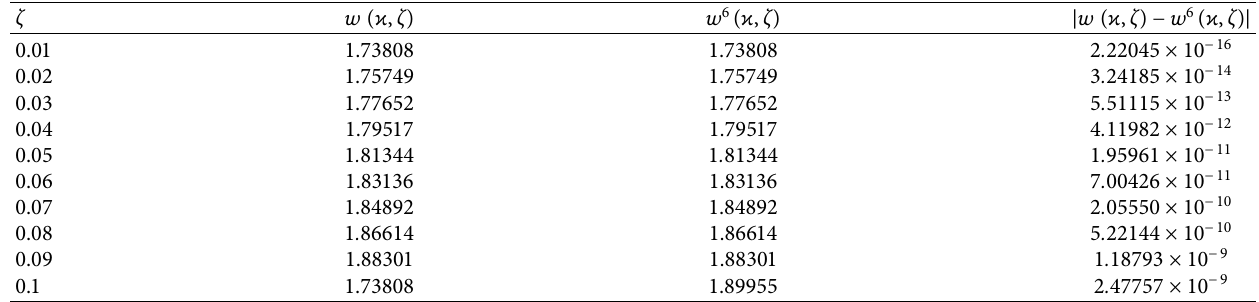
Table 11: | w ( ϰ , ζ ) − w 6 ( ϰ , ζ )| of Problem 3 at ϰ � 1 . 0 and λ � 2 . 0 when ϖ � 1 . 0 determined by LRPSM at plausible locations in the range